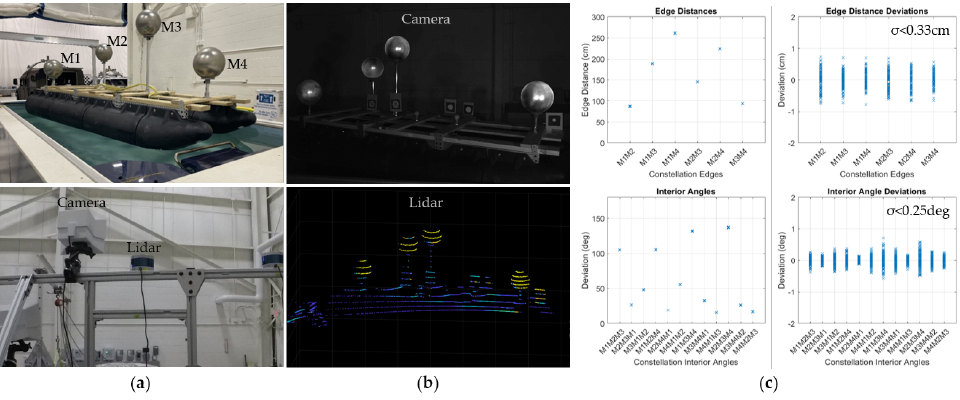
Figure 15. The in-lab test setup for precision-relative navigation is shown in ( a ). Example data frames from a near-infrared camera and LiDAR are shown in ( b ). Edge distances and interior angles calculated for tracking the ASV are shown in ( c ).